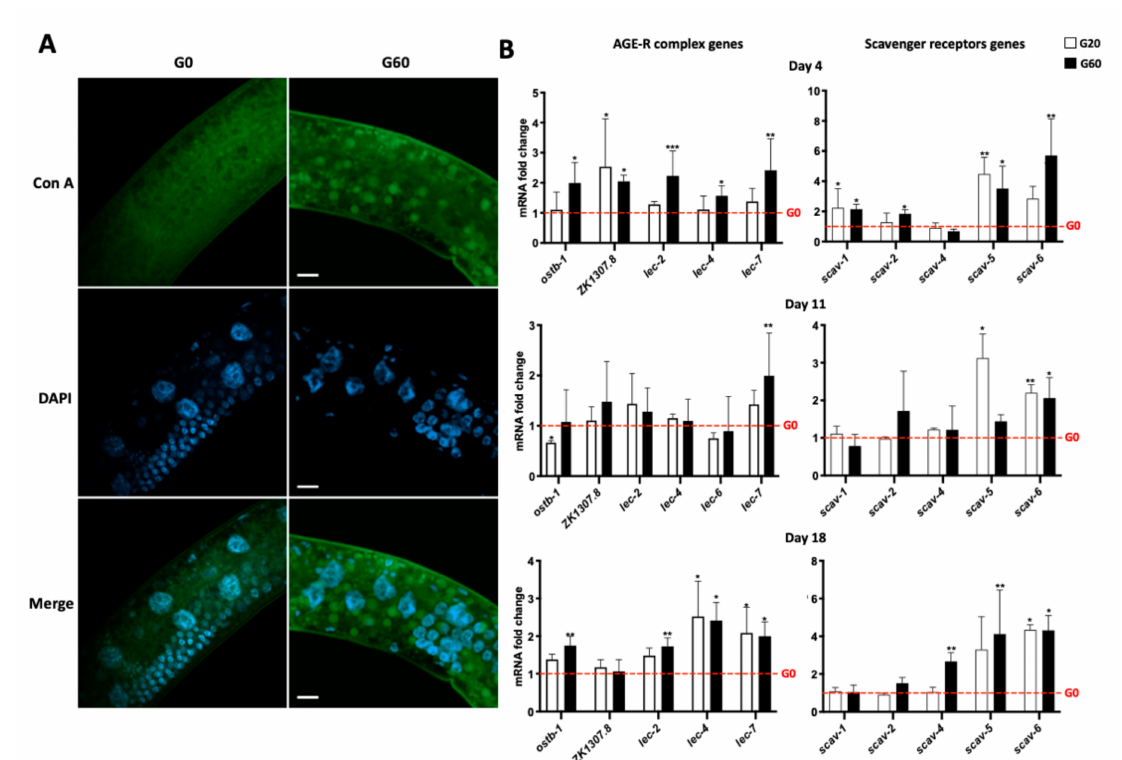
Figure 5. Specificity of endocytosis for dietary N ε -carboxymethyllysine and analysis of expression of advanced glycation end product (AGE) receptor encoding genes. ( A ) Worms fed for 4 days with bacteria, which were pretreated with 0 mM (G0) or 60 mM (G60) of glyoxylic acid, were fixed and permeabilized with modified Bouin’s solution and stained with concanavalin A (Con A). Worms’ nuclei were stained with DAPI. For each type of feeding condition, fluorescence micrograph with the mentioned DNA-binding probe or lectin are shown. Scale bars = 10 µ m. Endogenous glycoproteins were stained with Con A, a diffuse labeling is visible in the worms incubated with the control bacteria. All results are representative of 3 independent experiments. ( B ) Young adult worms were fed with G0, G20 (bacteria pretreated with 20 mM of glyoxylic acid) and G60. After 4, 11 and 18 days of culture, relative expression of mammalian ortholog coding for members of AGE-R complex and class A and B scavenger receptors, was analyzed by comparing all the conditions to the G0. Data were expressed as means ± standard deviation of 3 biological replicates. The cdc-42 and pmp-3 genes were used to normalize levels of gene expression. * p ≤ 0.05, ** p ≤ 0.01, *** p ≤ 0.001 G20 or G60 vs. G0 for the same incubation time (Kruskal–Wallis, Dunn’s multiple comparisons